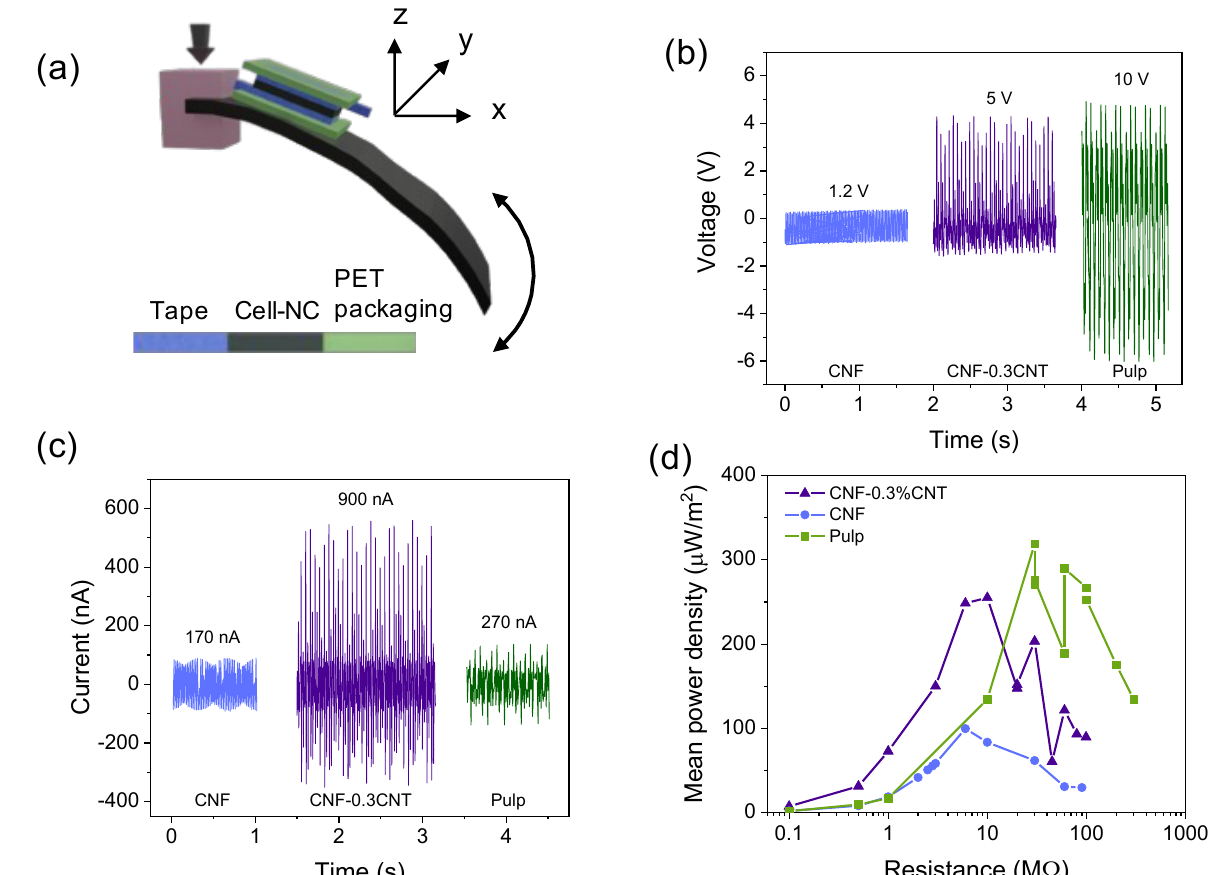
Figure 7. Cantilever excitation of piezoelectric response. Illustration of cantilever setup with sand- wiched film between current collectors ( a ). Piezoelectric open-circuit voltage ( b ), short-circuit current ( c ) and power–load curves ( d ) obtained from pulp, CNF and CNF-0.3%CNT